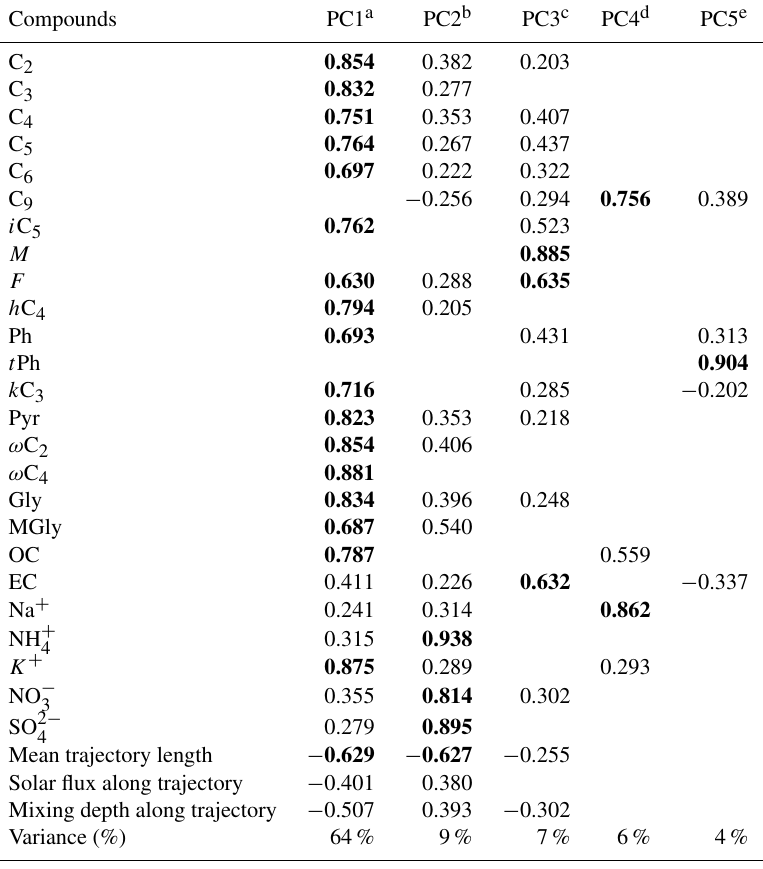
Table 3. PCA factor loadings for daytime DCRCs, OC, EC and inorganic ions as well as mean trajectory length, solar flux along trajectory and mixing depth along trajectory.